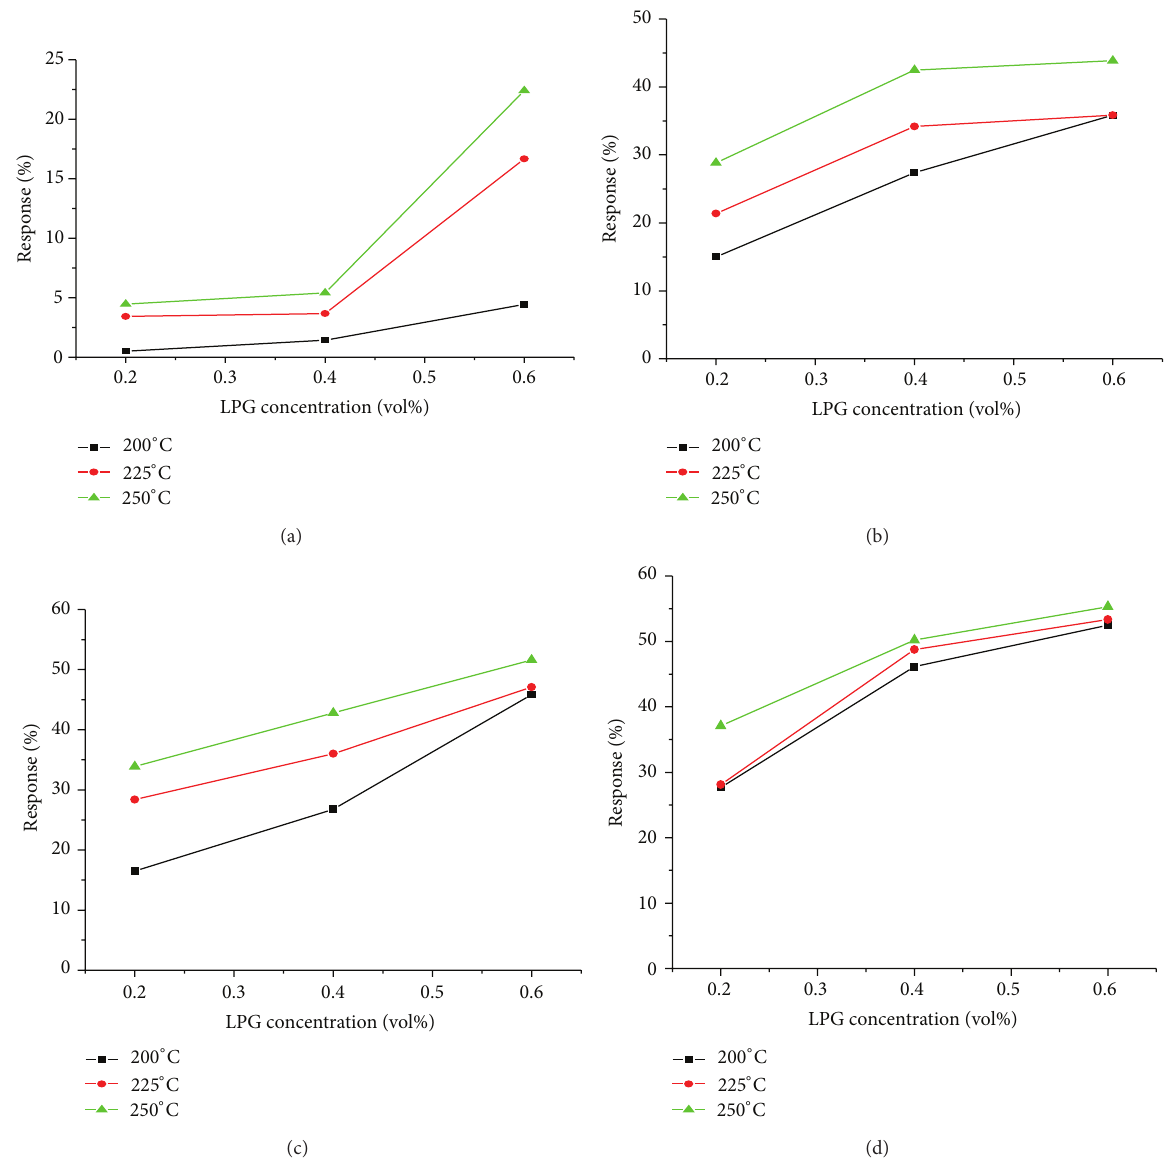
Figure 3: LPG response characteristics of (a) Zn 1.0 Cu 0.0 Fe 2 O 4 , (b) Zn 0.75 Cu 0.25 Fe 2 O 4 , (c) Zn 0.50 Cu 0.50 Fe 2 O 4 , and (d) Zn 0.25 Cu 0.75 Fe 2 O 4